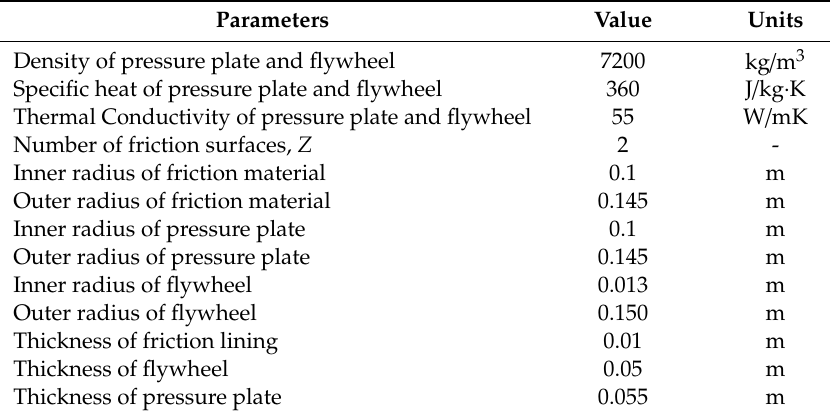
Table A4. Input parameters for the clutch thermal